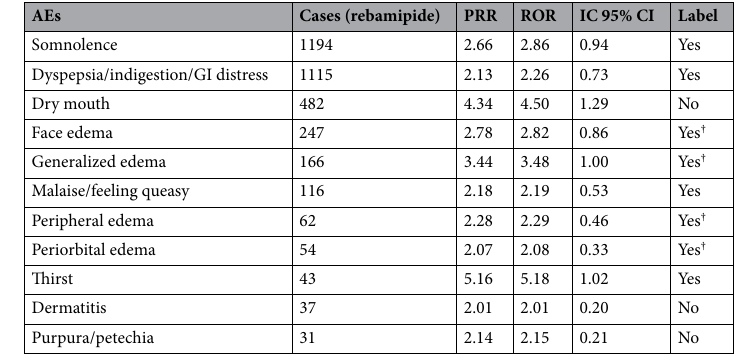
Table 1. AE signals of rebamipide (analysis of drug–AE pairs classified as certain, probable, or possible). AE adverse event, CI confidence interval, GI gastrointestinal, IC information component, PRR proportional reporting ratio, ROR reporting odds ratio. † Labels including edema.